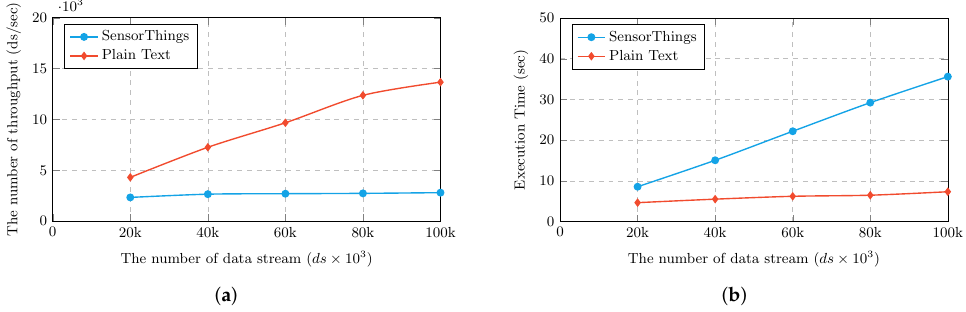
Figure 1: The comparison between two different data sources 1) SensorThings, and 2) Plain Text in two metrics including throughput and execution time Figure 6. The comparison between two different data sources (1) SensorThings, and (2) Plain Text in two metrics including throughput and execution time: ( a ) The relationship between throughput and the number of data streams; ( b ) The relationship between execution time and the number of data